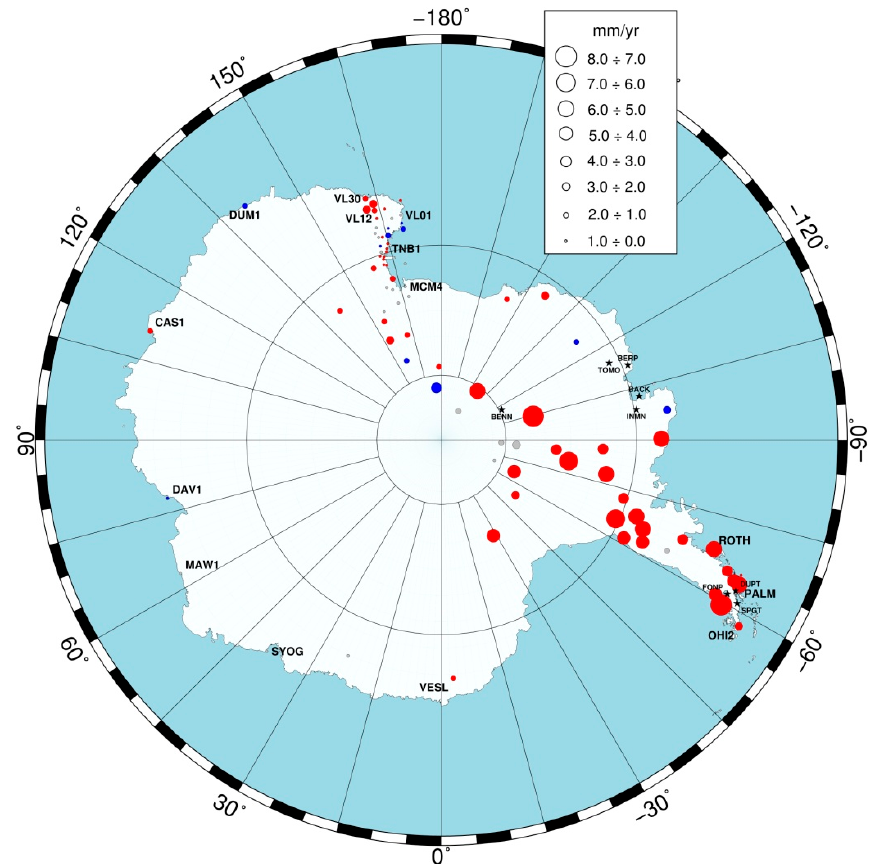
Figure 7. Vertical rates (mm/yr) detected at continental scale. Red dots denote uplifting sites, blue dots denote subsiding sites, black stars represent the out of range displayed values (BENN 10.8 ± 1.46 mm/yr, BERP 28.9 ± 2.3 mm/yr, DUPT 12.0 ± 0.74 mm/yr, FONP 13.9 ± 0.77 mm/yr, SPGT 10.2 ± 1.29 mm/yr, TOMO 55.4 ± 3.58 mm/yr; Supplementary Materials, Table S4); gray dots show not significant movements (± σ ).